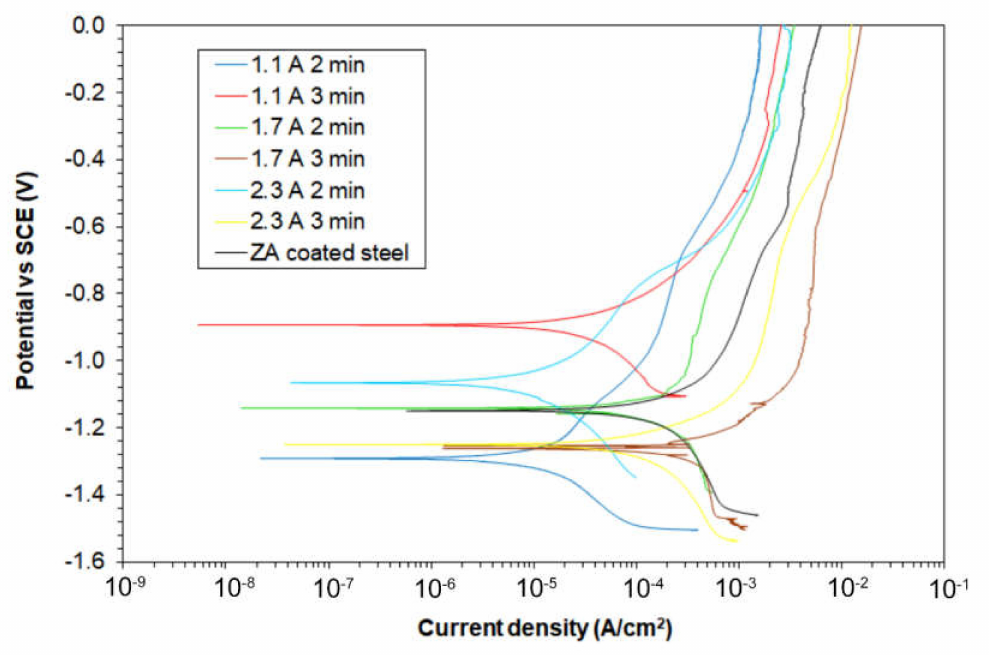
Figure 5. Potentiodynamic polarization curves for the di ff erent samples (test solution: 0.1 M Na 2 SO 4